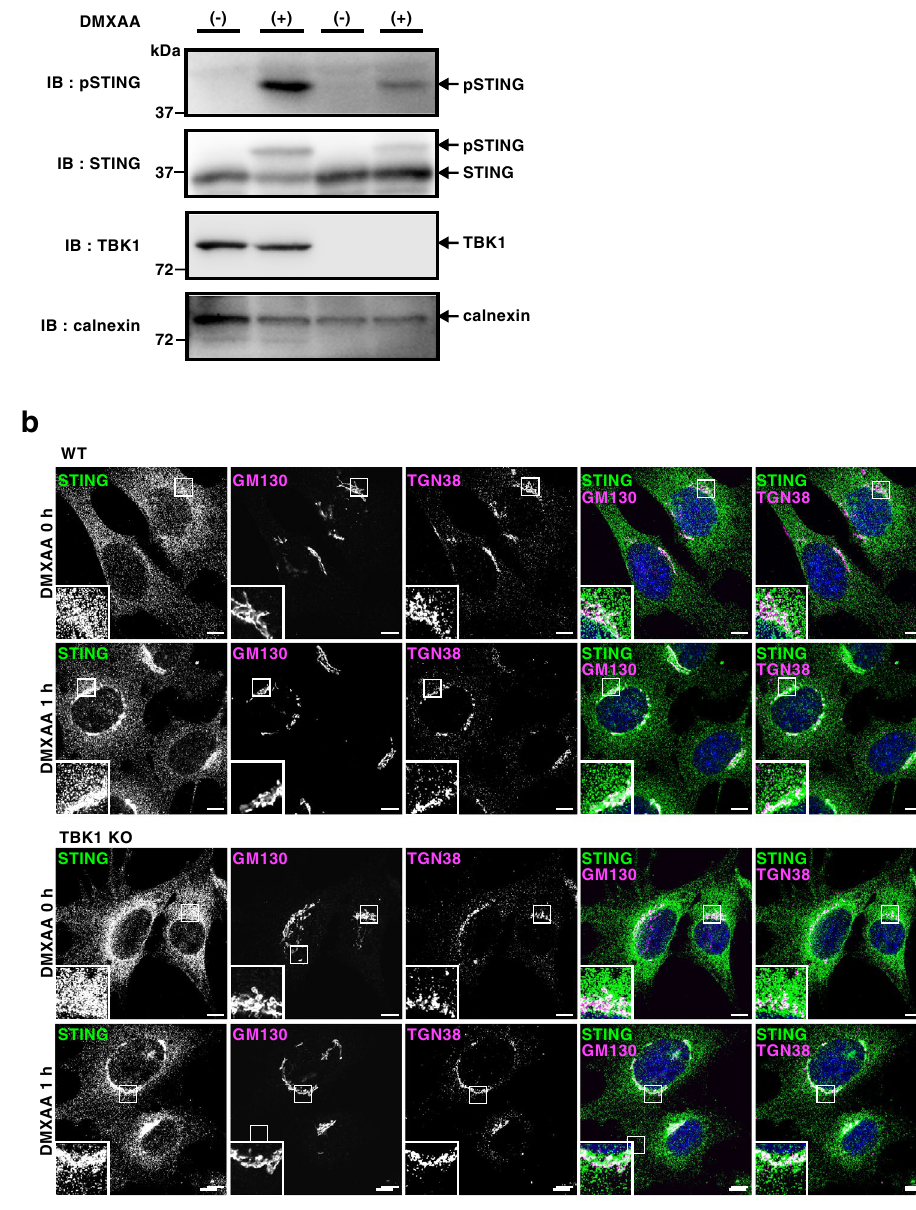
Figure 1. Generation of TBK1-knockout MEFs. ( a ) Western blots of cell lysates of WT or TBK1-knockout MEFs stimulated with DMXAA for 1 h. ( b ) Cells were stimulated with DMXAA for 1 h, fixed, permeabilized and stained for endogenous STING, GM130 (a cis-Golgi protein) or TGN38 (a trans-Golgi network protein). Nuclei were stained with DAPI (blue). Scale bars, 10